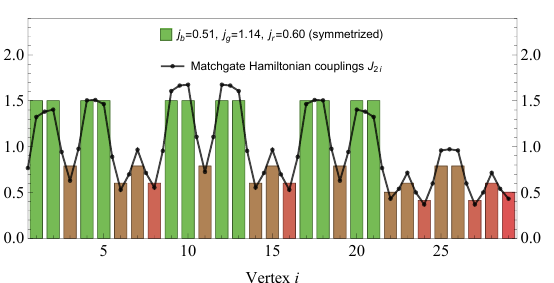
Figure 6 . Construction of a multi-scale quasicrystal ansatz (MQA) for coupling sequences with the symmetries of { 3 , 7 } tiling layers. (a) The MQA of ref. [37] composed of inflation layers following the rule (2.2). The sequence directly below each letter is generated by applying (2.2) to that